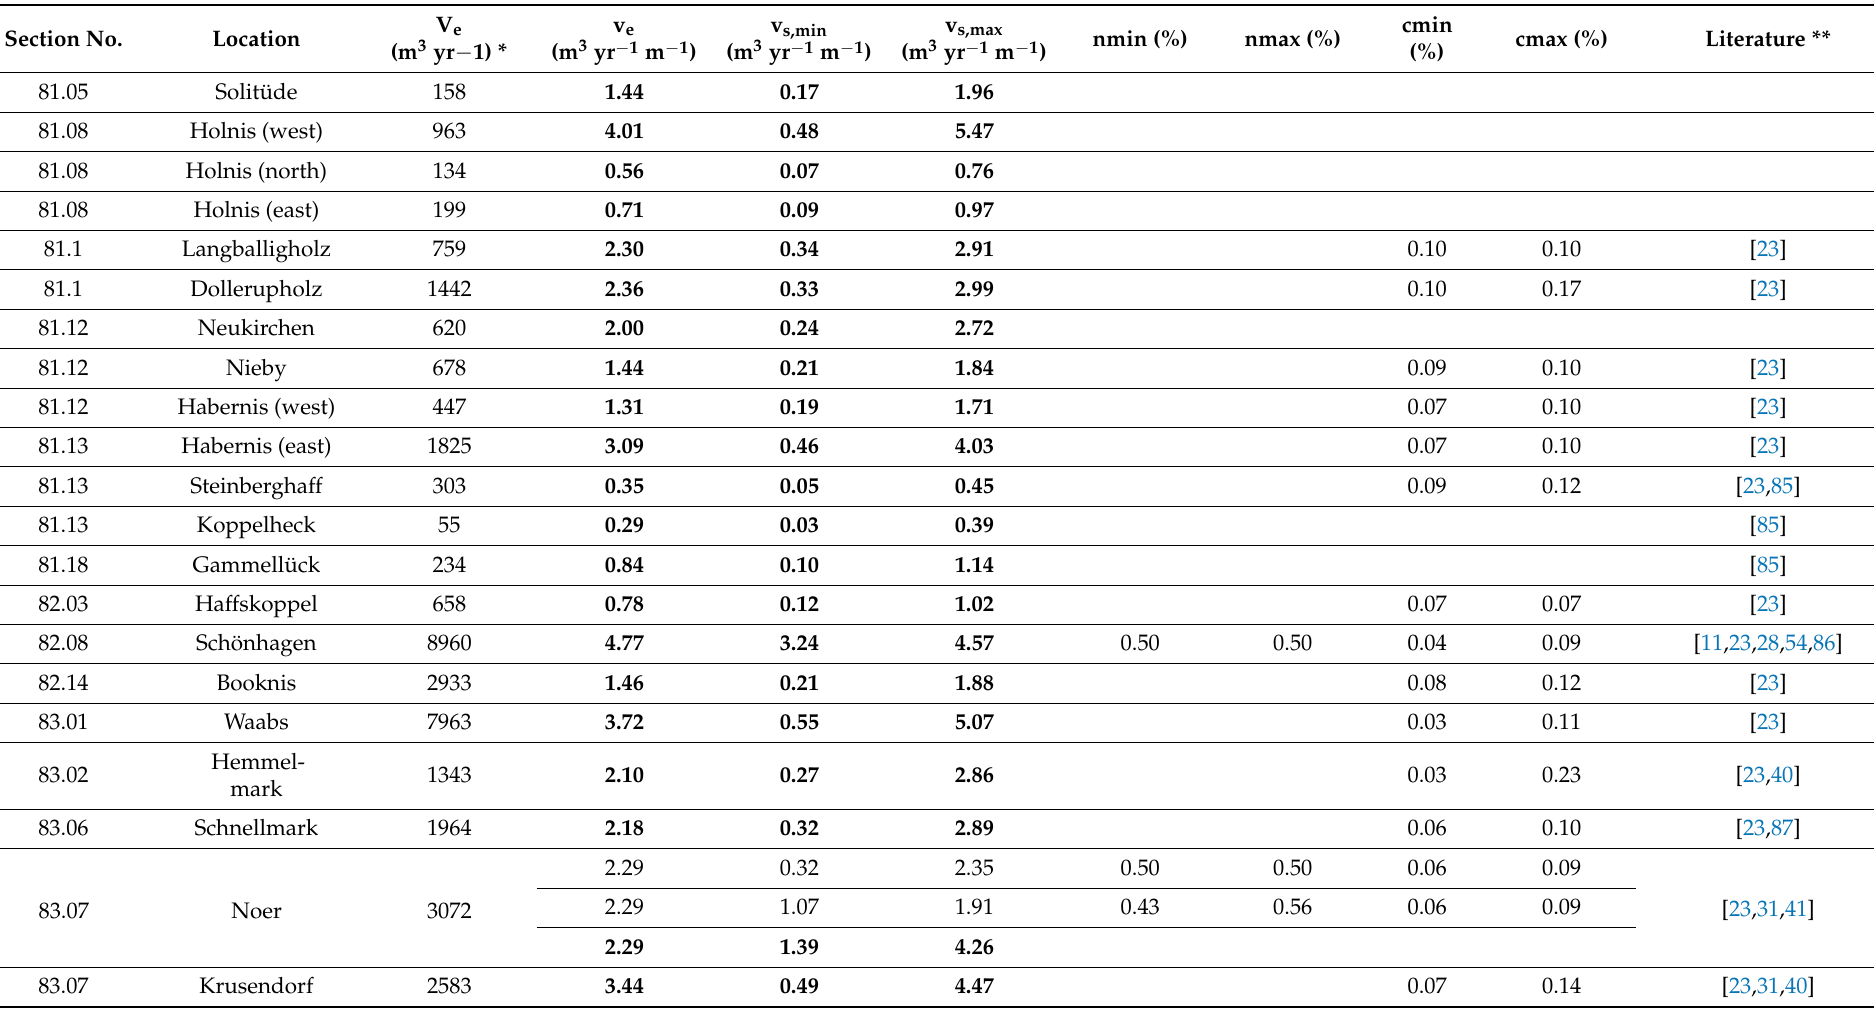
Table A2. Database of the littoral sediment budget assessment. Values of V e are based on [36] *. Geological/sedimentological information was provided by the listed literature **. Calculations of v s,min and v s,max for sections with missing data for n, c were based on min/max estimates derived from local data (Table 2). Section